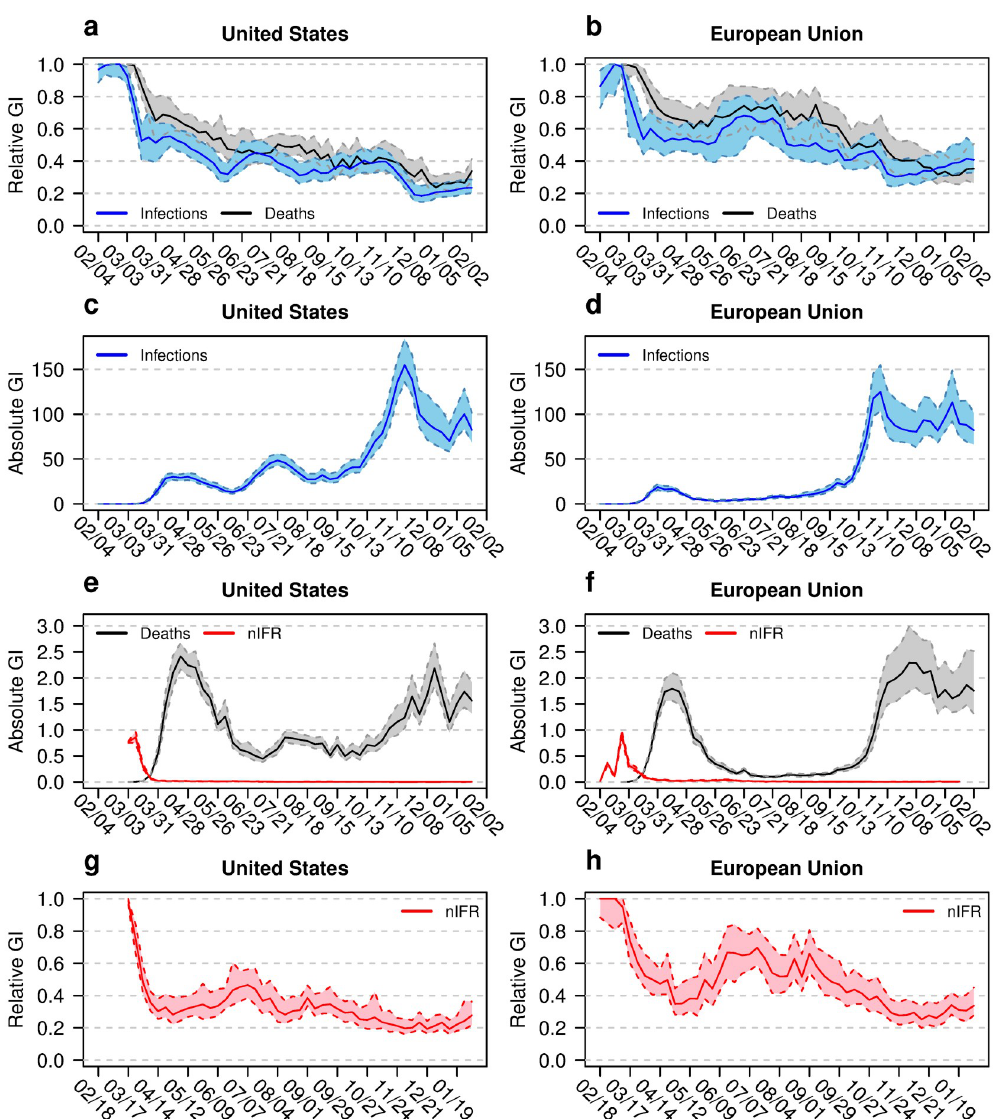
Fig 4. Inequality measures for the United States and the European Union. Gini indices (GI) for the states of the United states (left column) and the member states of the European Union (right column). Shown are the relative GIs of infections and deaths (blue and black curves, a and b), absolute GIs of infections (c and d), and absolute GIs of deaths and naive infection fatality rate nIFR (e and f) as well as relative GI for nIFR (g and h). The coloured bands show the 95% confidence intervals. The horizontal axis shows the time between February 2020 and February